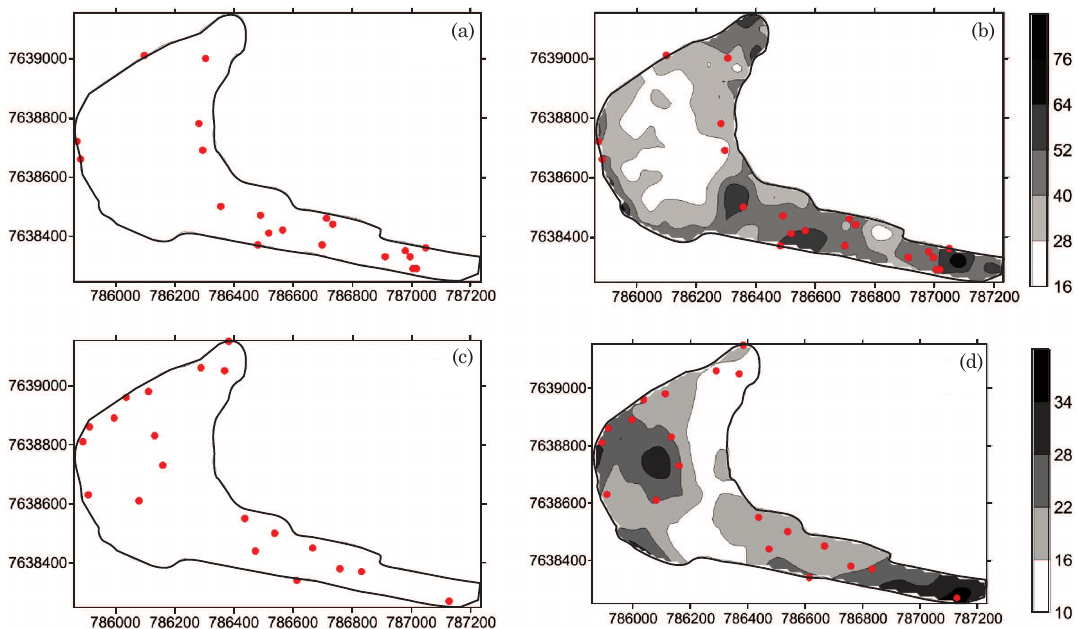
Figure 3. The two optimal sampling schemes, showing the locations of additional points (red dots) for the chemical properties (a), physical properties (c), optimal sampling scheme applied to the kriging map of the calcium content (b) and scheme applied to the kriging map of the coarse sand content